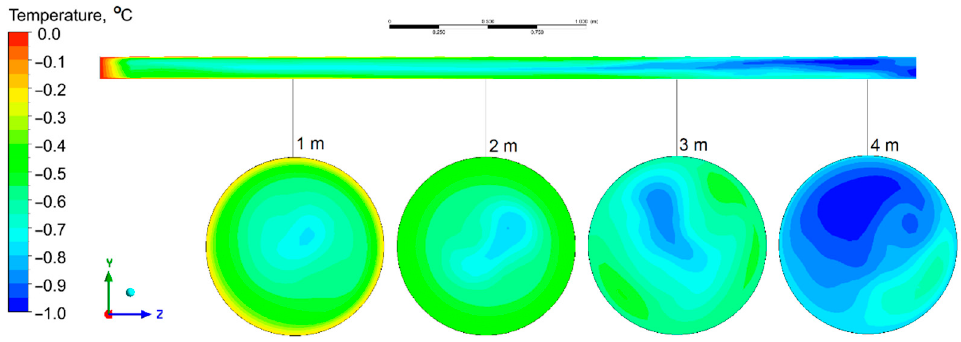
Figure 6. Distributions of the vertical velocity component in the longitudinal and transverse cross sections of the borehole near its bottom.